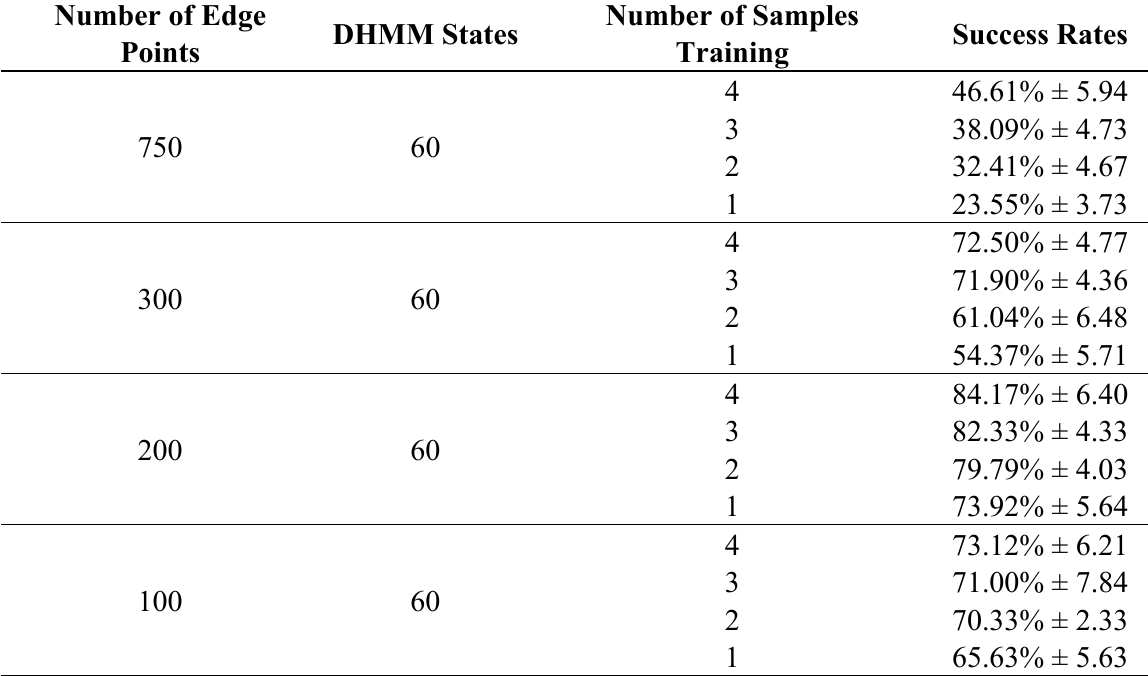
Table 2. Success rates for DHMM classifier, using edge information for 60 users.